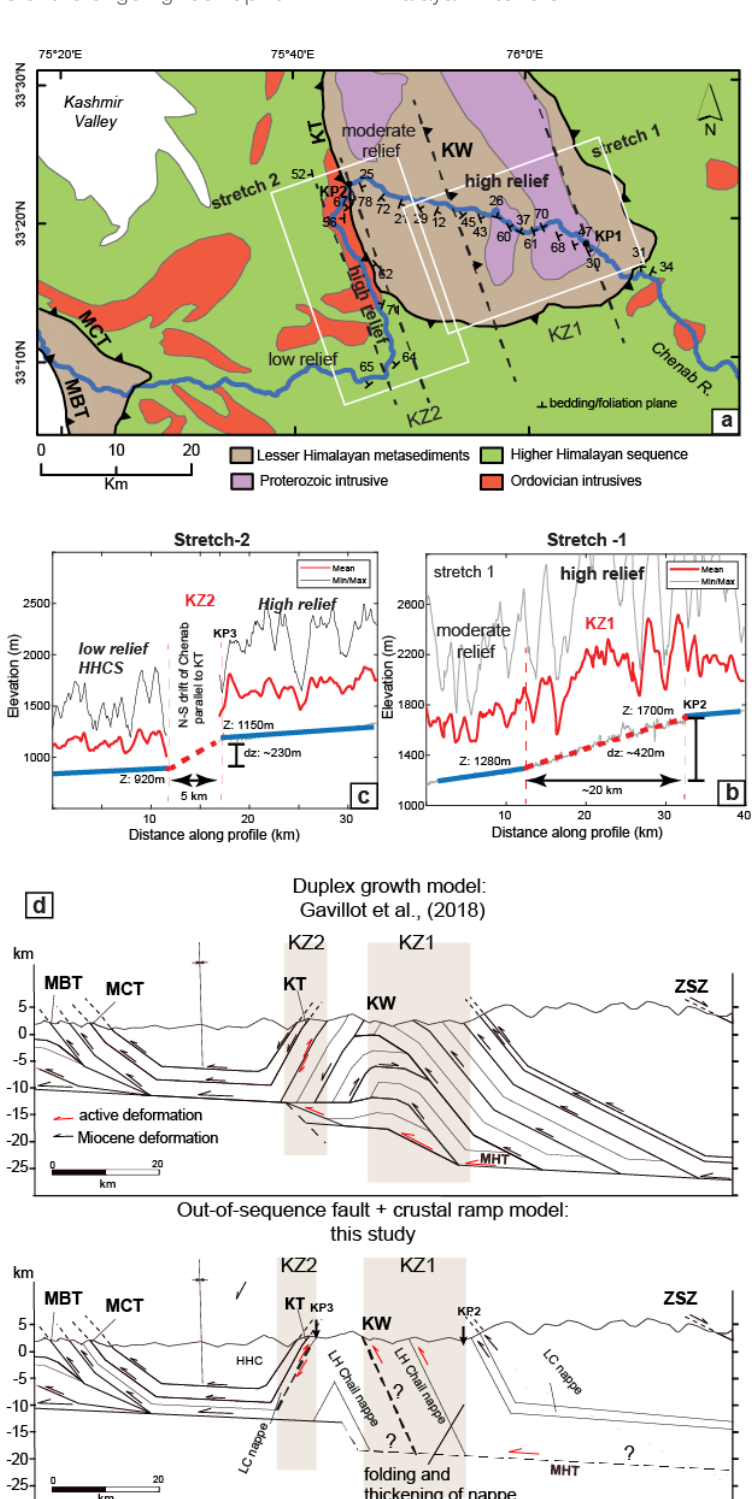
Figure 8. (a) Detailed structural data from the study area showing structural and lithological variations (modified after Steck, 2003; Gavillot et al., 2018). (b, c) Orogen-perpendicular drop of the Chenab trunk stream across stretch 1 and stretch 2, respectively, showing a transient increase in steepness over the K1 and K2 knickzone. The orthogonal profile projection method has been used in the case of K2 (see Fig. 7) to identify the width of the steep segment. (d) Comparison between two deformation models explaining the observed morphometric variations across the KW: (a) duplex growth model (adapted from Gavillot et al., 2018) and (b) active out-of-sequence fault model.